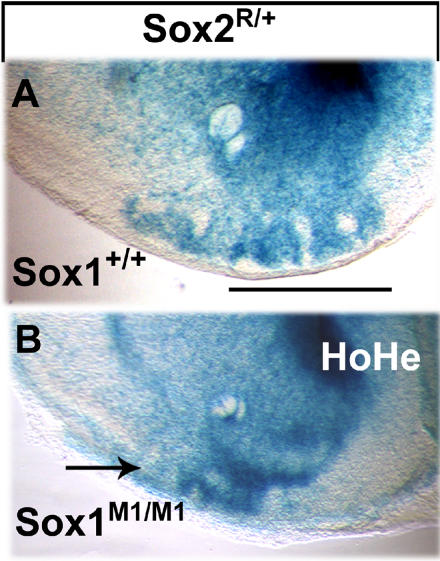

Sox1 Expression in Postmitotic LGE Cells Is Sufficient for Neuronal Migration in the VSX-gal staining of coronal sections from the ventral telencephalon of P0 mice indicating the migration of neurons expressing SOX1 from the Sox2
R allele in the presence (A) and absence (B; HoHe) of endogenous Sox1 wild-type genes. Black arrow points at the striatal bridges forming in HoHe mice. Scale bar = 100 μm.